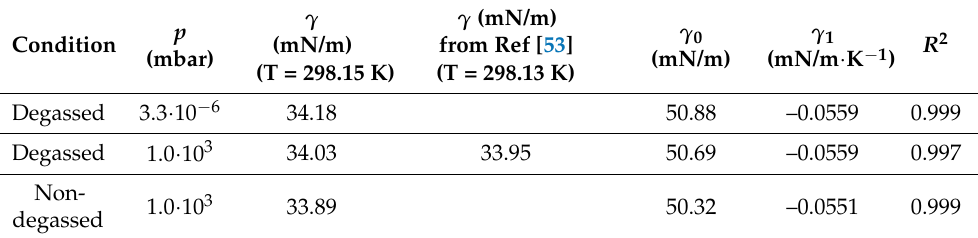
Table 2. Surface tension of [C 8 C 1 Im][PF 6 ] at different pressures under degassed and non-degassed conditions (different water content) at 298.15 K. The surface tension values are calculated using